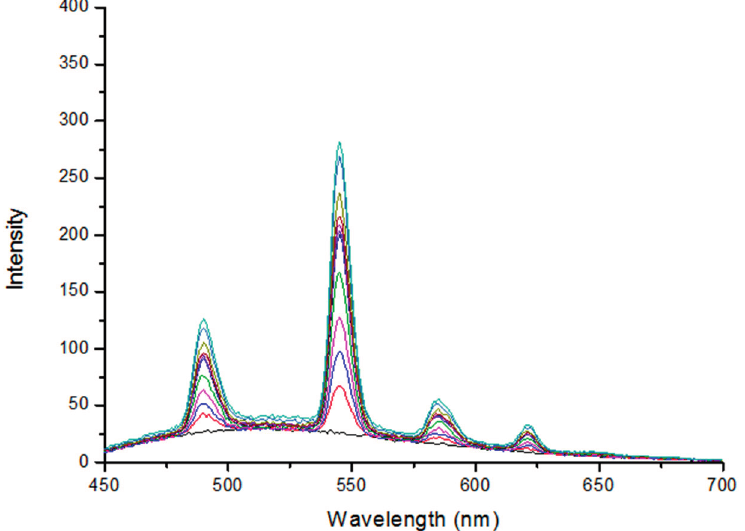
Figure 5. Fluorescence spectra of the Tb 3+ -TBP-19-TagRFP sensor before ( a ) and after ( b ) the correction for reabsorption. Measurements were performed using 280 nm excitation wavelength and a time delay of 100 μ s, gate 1 ms in the phosphorescence mode. Spectra are arranged one above the other with the terbium concentration increase from 1 to 50 µM. In order to calculate the TagRFP fluorescence without the contribution of terbium fluorescence, it was necessary to carry out the titration of terbium-binding peptide linked to the TagRFP protein with photobleached chromophore using Tb(NO 3 ) 3 solution as described in [26]. The results of that titration are shown in Figure 6.